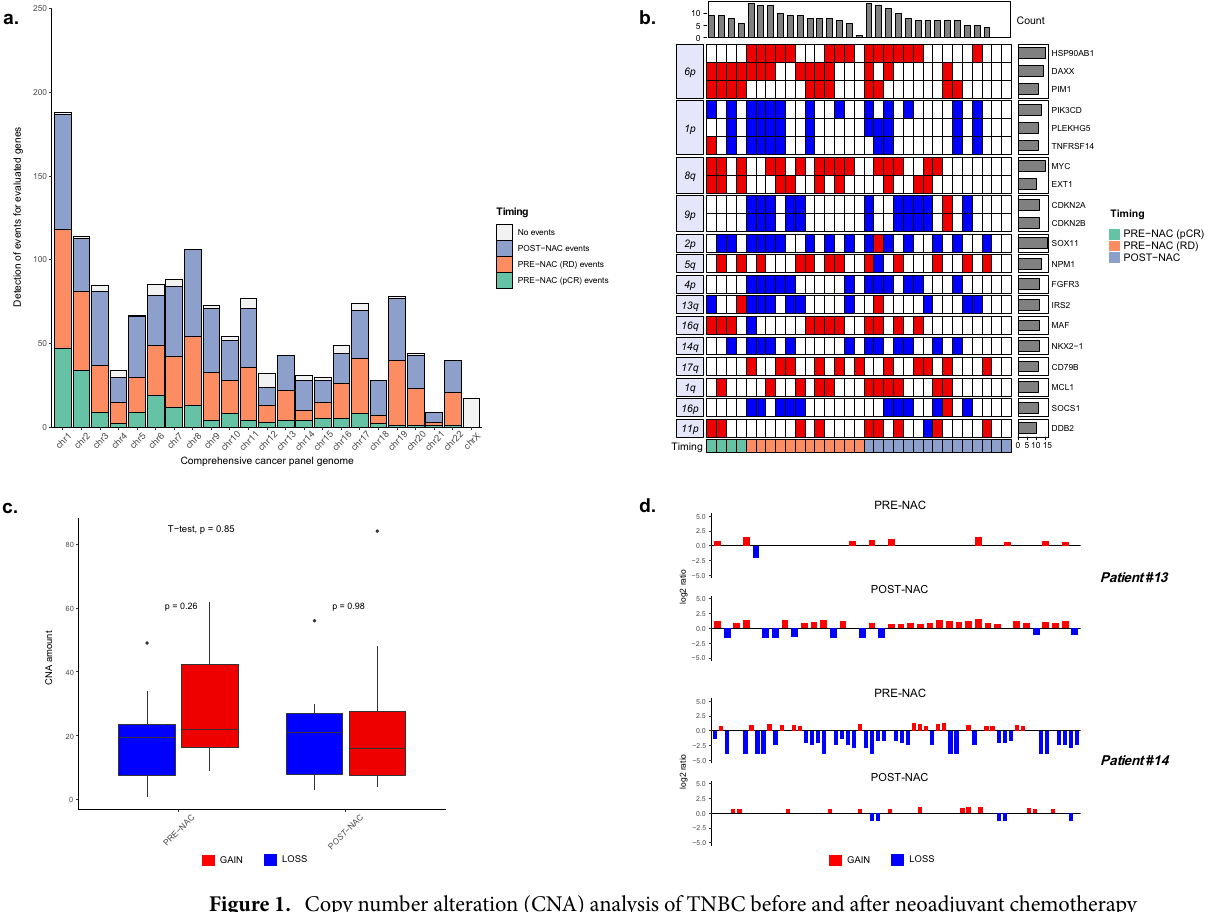
and 8, and SOX11 and MYC were among the top-twenty altered genes (54% and 48% of cases, respectively), two findings consistent with previously reported literature data (Fig. 1a) 10 . When focusing on pre-treatment samples (mean cellularity = 70%), HSP90AB1 (chr 6p), CDKN2A/B (chr 9p), FGFR3 (chr 4p), CD79B (chr 7q), and SOCS1 (chr 16p) were found unaltered in the four patients attaining a pathological complete response, possibly suggesting that these genes are important for maintaining a chemosen- sitive profile (Fig. 1b). Furthermore, gains of MSH2 (chr 2p) and PRDM1 (chr 6q) exclusively characterized the pCR patient group (4/4 versus 0/12, p < 0.01), and loss of PAX3 (chr 2q) occurred in primary tumor samples of all patients with pCR and in a single case with residual disease at surgery (4/4 versus 1/12, p < 0.01) (Table S3). The network analysis of physical interactions between MSH2, PRDM1 and PAX3 genes, i.e. , identified in responsive cases, reported a functional module of seven nodes including the mismatch repair, intrinsic apoptotic, Notch, Wnt, androgen receptor, HIF-1 signaling pathways, and platinum drug resistance (Figure S1). CNA events occur- ring in the paired pre- and post-treatment samples are summarized in Table 1. Overall, not a single case reported a post-treatment (mean cellularity = 73%) CNA profile identical to base- line; however, all cases had at least one common event in the paired analyses (Figure S2). The median number of CNAs following NAC was 45.5 in pre-treatment as compared to 38.5 of post-treatment samples ( p = 0.85, Fig. 1c). More in detail, in 5 out of 12 (42%) patients, CNAs increased after NAC, with a median number of amplifications and deletions of 27 (range: 19–84) and 21 (range: 9–56), respectively (Table S4). Patient#13 who